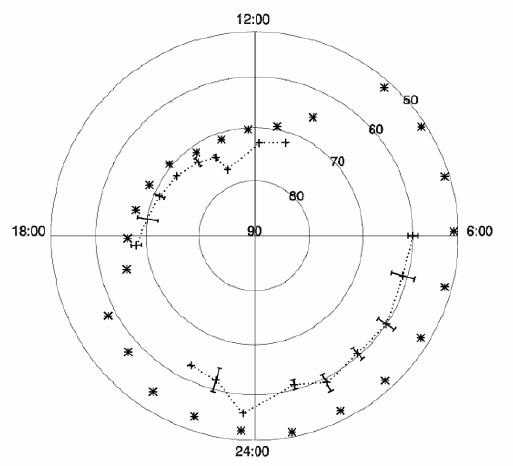
Fig. 12. Polar plot in the magnetic reference frame comparing average locations of the trough minimum under quiet geomagnetic conditions obtained from tomographic images ( + ) with estimates by the SUCTIP model ( ∗ ). From Balthazor et al. (2002).